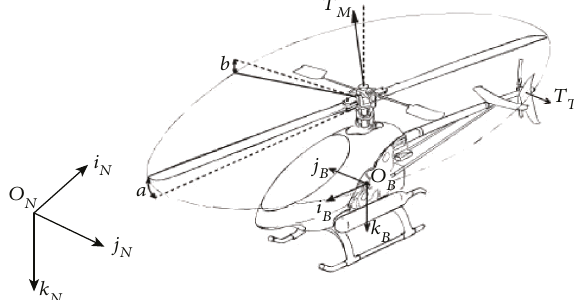
Figure 1: Schematic diagram of a small-scale unmanned